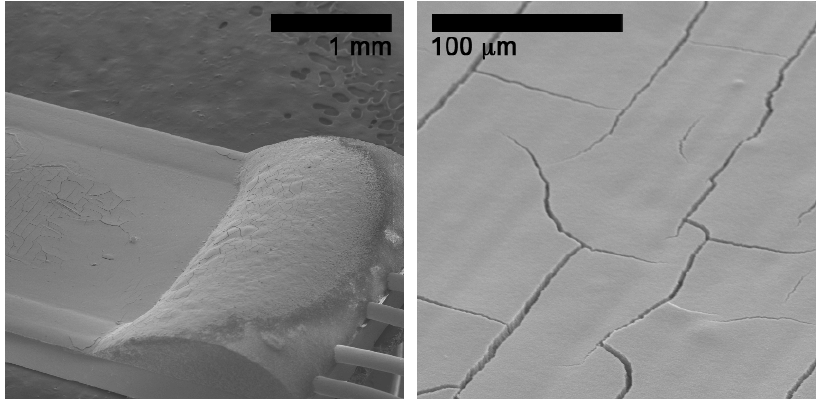
Figure 11. SEM images of a single layer of tin dioxide film deposited using the dispersion- drop